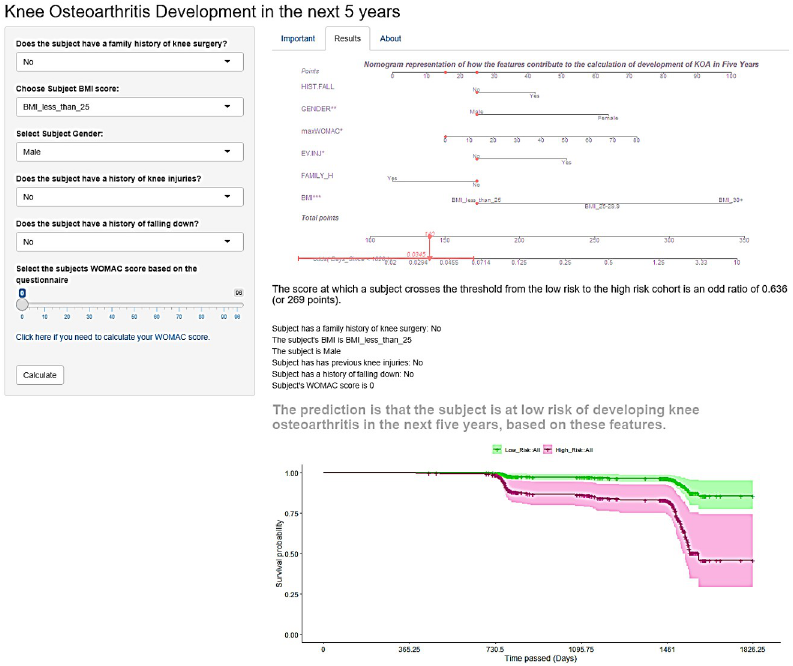
Fig 7. Prognostic app interface built in R Shiny. The app has multiple-choice options that relate to symptoms linked to the progression from a disease free state to KOA onset. The app also includes the option to link to the WOMAC questionnaire, should the participant not know their score. This app was built using R Shiny